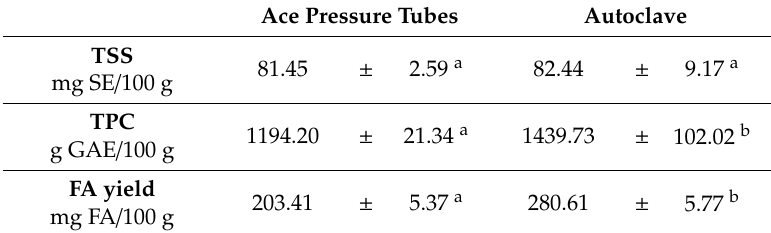
a indicates not significant di ff erences and b indicates significant di ff erences.